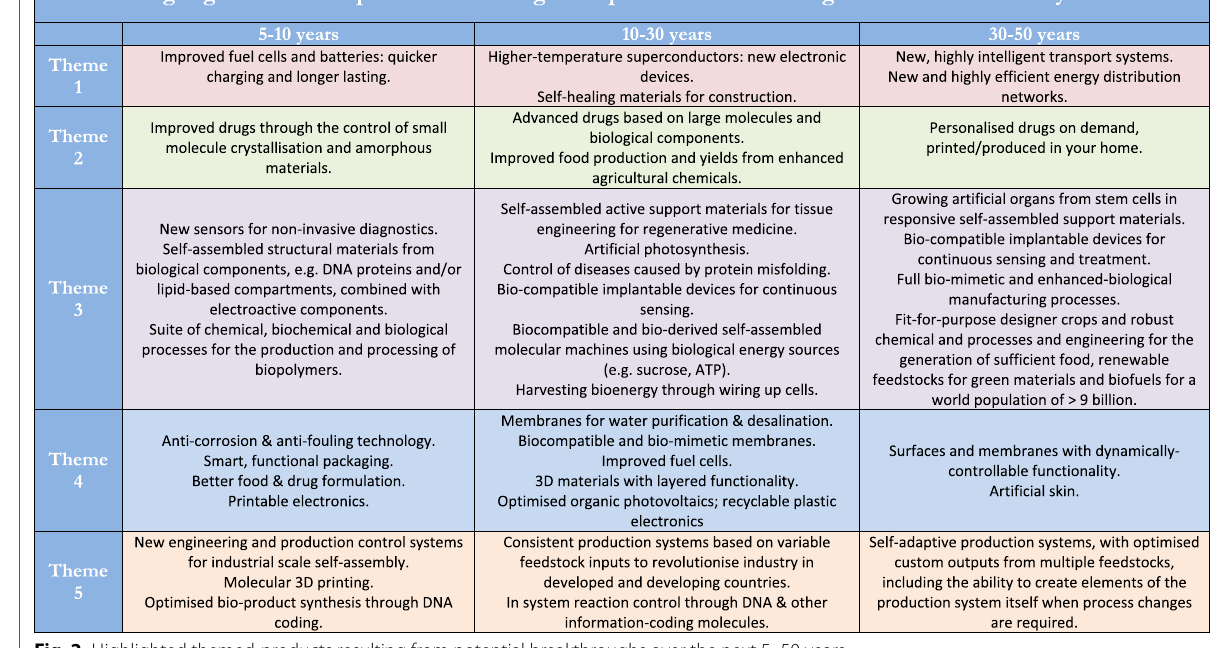
Fig. 2 Highlighted themed-products resulting from potential breakthroughs over the next 5–50